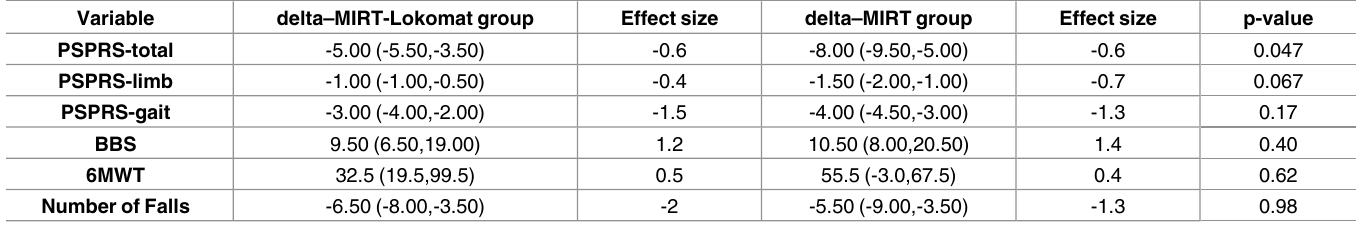
Table 3. Difference(discharge-admission) of the outcome variables for MIRT+Lokomat group and MIRT group and effect size. Reported p-values are computedby the Mann–Whitney U